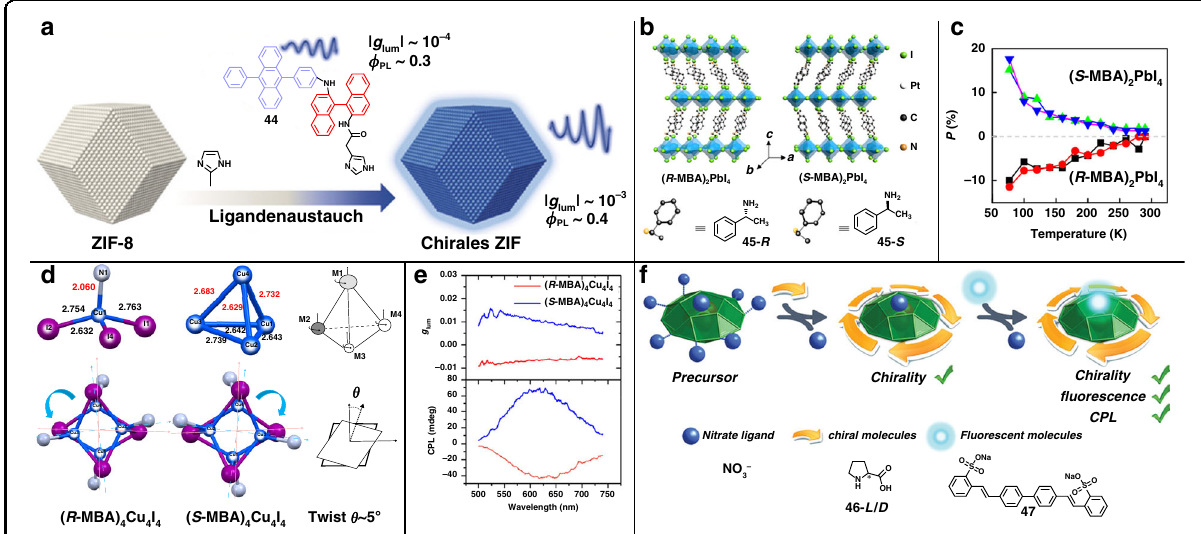
Fig. 5 CPL from the assembly of chiral ligands on achiral nanotemplates. a Amplifying CPL by assembly the chiral luminescent molecule onto the achiral ZIF-8 skeleton. b Schematic illustrations of crystal structures of ( R / S -MBA) 2 PbI 4 . c The in fl uence of temperature on the photoluminescence polarization of ( R / S -MBA) 2 PbI 4 . d The con fi guration features of ( R / S -MBA) 4 Cu 4 I 4 . e The CPL spectra of ( R / S -MBA) 4 Cu 4 I 4 . f Schematic diagrams of the stepwise surface modi fi cation for Ag(I) clusters. Images reprinted with permission from: a ref. 77 from Wiley; b , c ref. 82 , d , e ref. 92 from ACS; f ref. 93 from